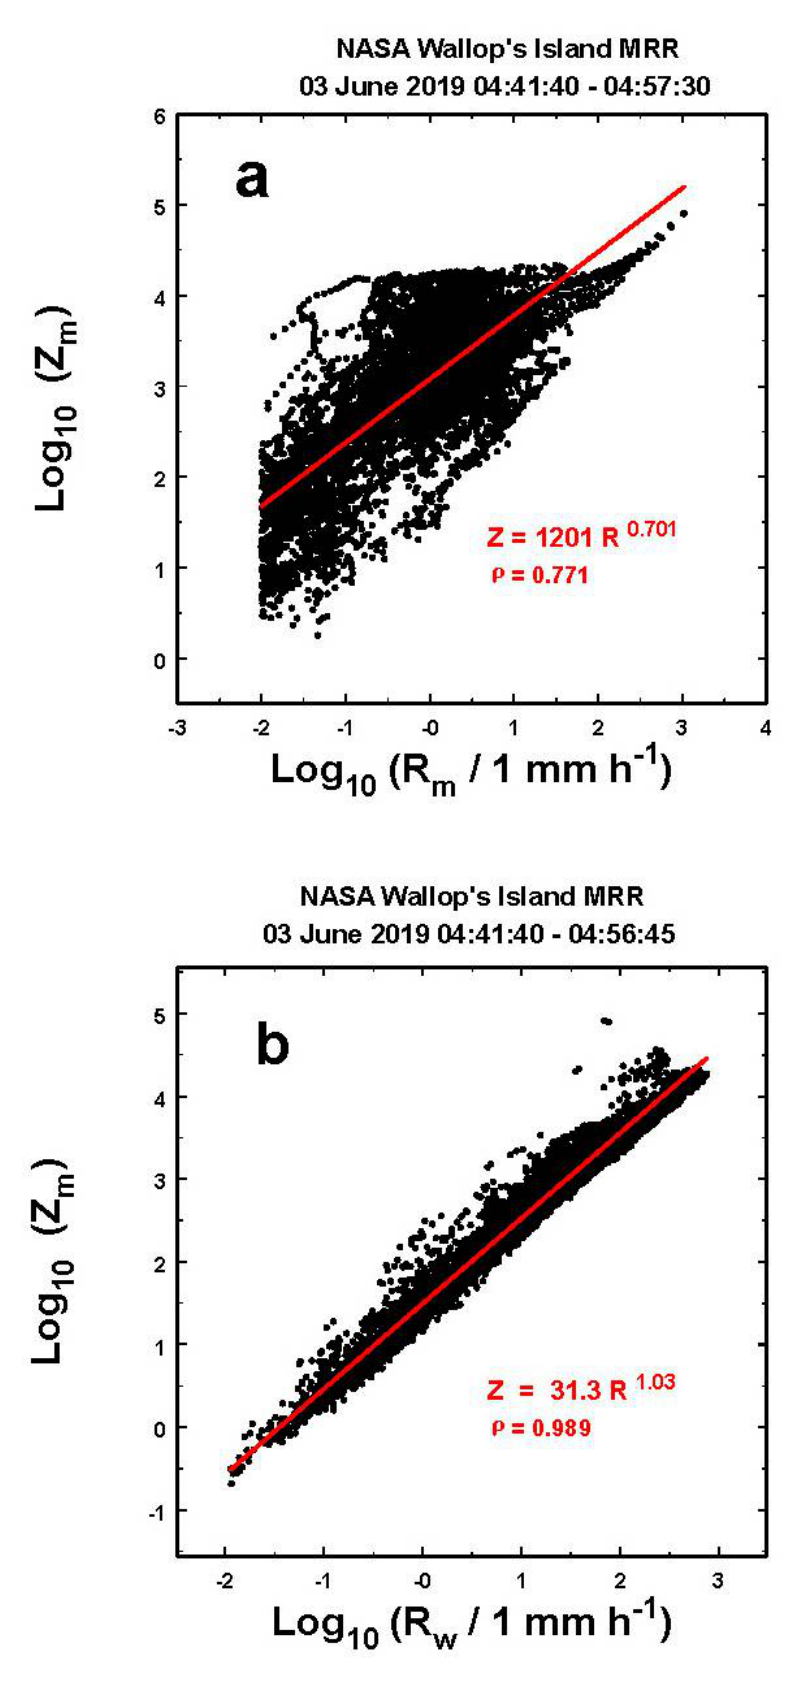
Figure 18. Z – R correlations derived ( a ) for the measured rainfall rates ( R m ) from the MRR processor and ( b ) those corrected for vertical air speed ( R w ), as discussed further in the text.